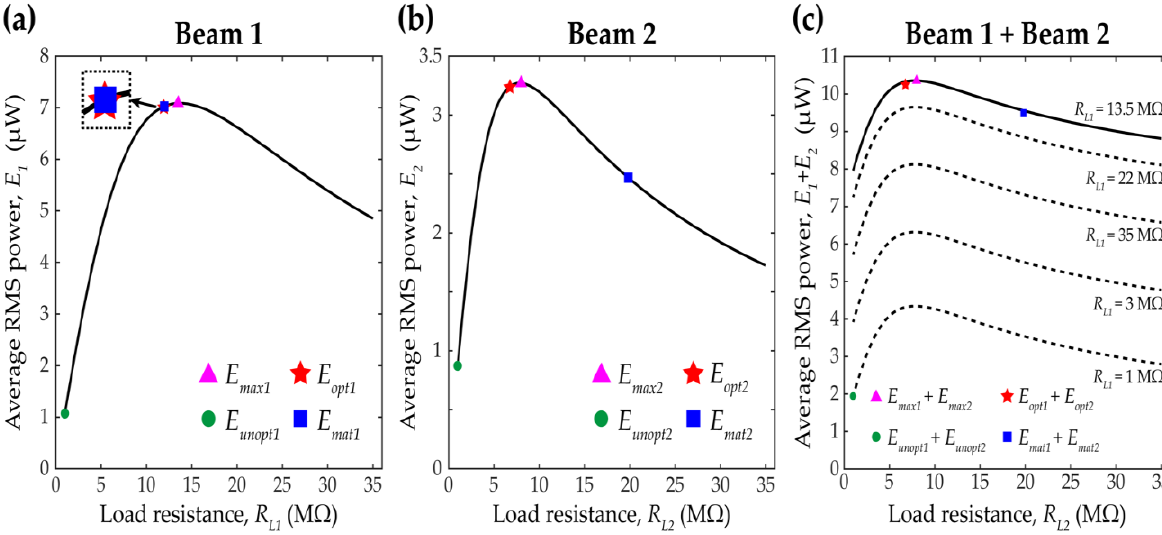
Figure 9. Average RMS power results for beam 1 and beam 2 are shown in ( a , b ), respectively, with changing external load resistances. ( c ) shows the summation of ( a , b ). Each resistance varies from 1 M Ω to 35 M Ω with increments of 0.5 M Ω for the simulations. The average RMS power of beam 1 is assumed to be independent of the load resistance of beam 2, and vice versa. The load resistance of beam 2 is set to be 8 M Ω for ( a ), and the load resistance of beam 1 is chosen as 13.5 M Ω for ( b ). The magenta triangle marker denotes the maximum average RMS power. The red star marker indicates the average RMS power obtained when the resistance is optimized at the excitation frequency of 17.5 Hz; on the other hand, the blue square is obtained with the matched resistances at the same excitation frequency. For comparisons, the average RMS power with the resistances of 1 M Ω is denoted by the green circle marker.